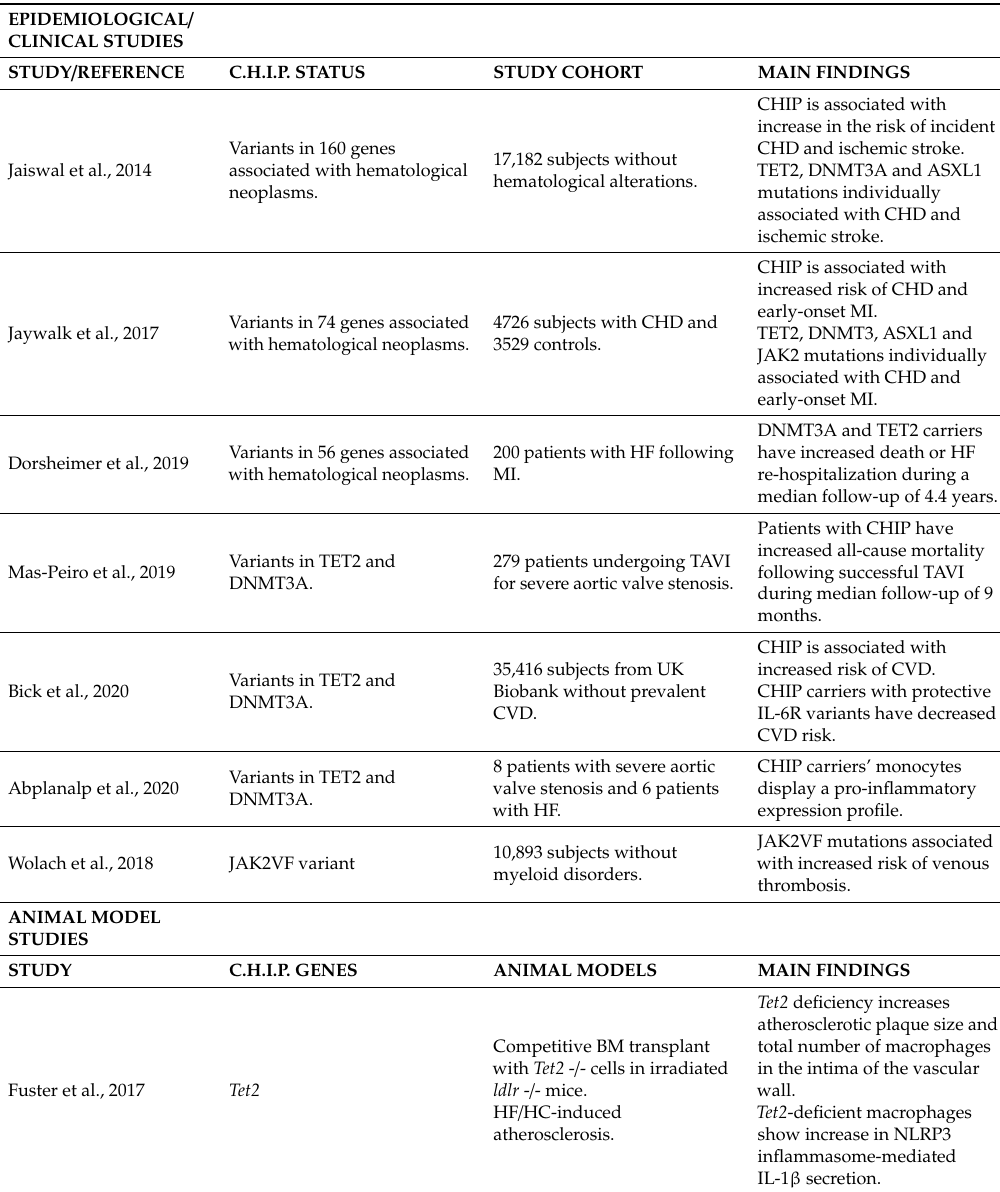
Table 3. List of studies investigating the link between CHIP and CVD in patients and animal models. BM, bone marrow; CHD, coronary heart disease; CVD, cardiovascular disease; HF, heart failure; HF / HC, high fat / high cholesterol; HSPC, hematopoietic stem / progenitor cells; LAD, left anterior descending artery; ldlr, low-density lipoprotein receptor; TAC, transverse aortic constriction; TAVI, transcatheter aortic valve